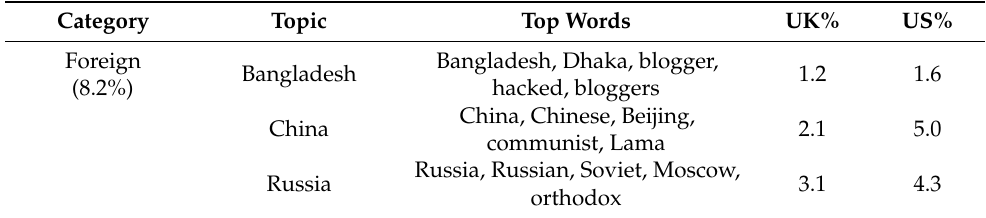
Table 2. Overview of the 15 substantive topics in the atheist corpus.